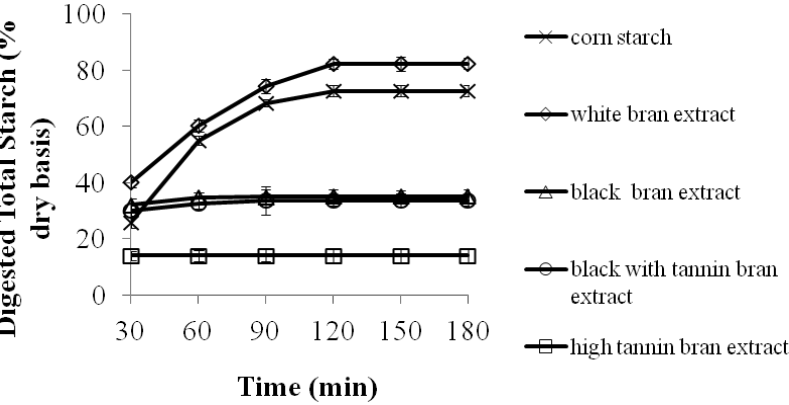
Figure 1. Starch digestibility of corn starch porridge made with sorghum bran extracts as a function of time (porridges used the equivalent of 50 mg of starch on a dry weight basis). Values are means ± standard error of n = 3 samples per